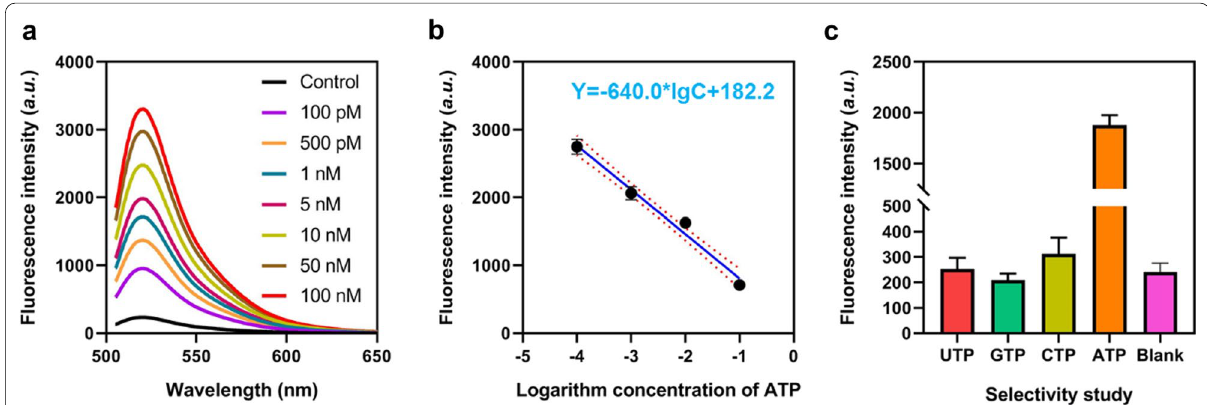
Fig. 4 Detection performance of the method. a Fluorescence spectrum of the approach when detecting different concentrations of ATP; b correlation equation of the obtained signal and ATP concentration; c fluorescence intensity of the approach when detecting UTP, CTP, GTP and ATP